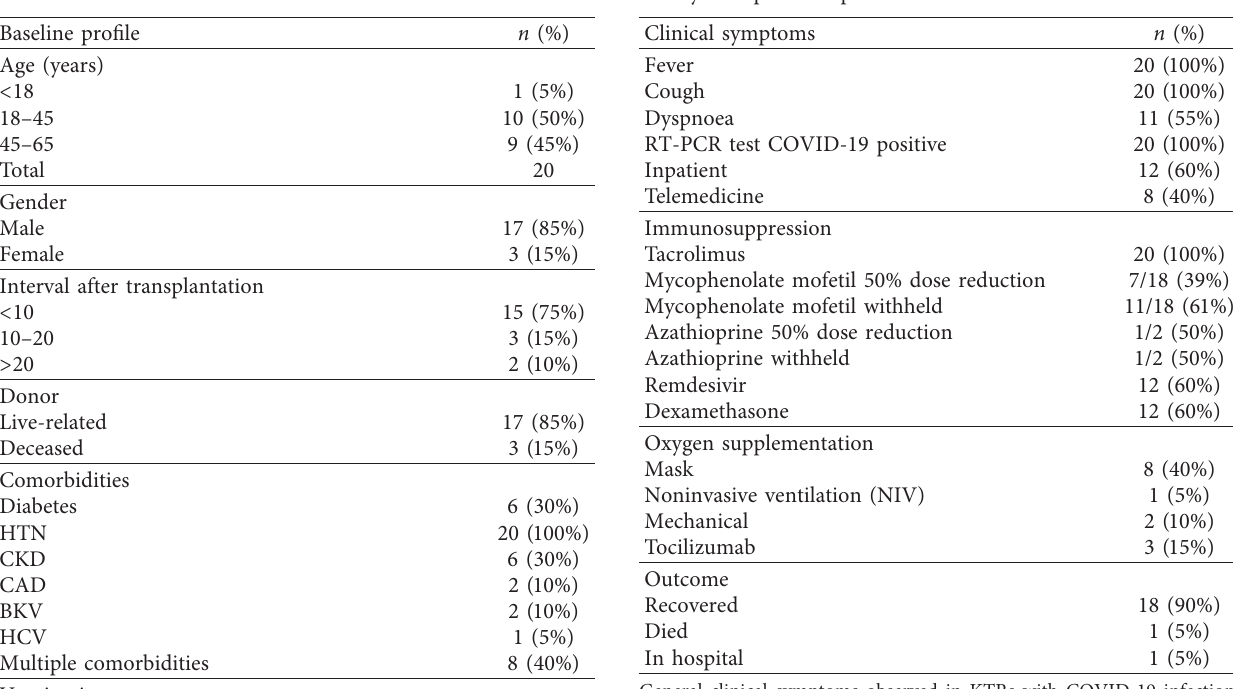
Table 2: Clinical symptoms, treatment modalities, and outcomes of kidney transplant recipients with COVID-19.